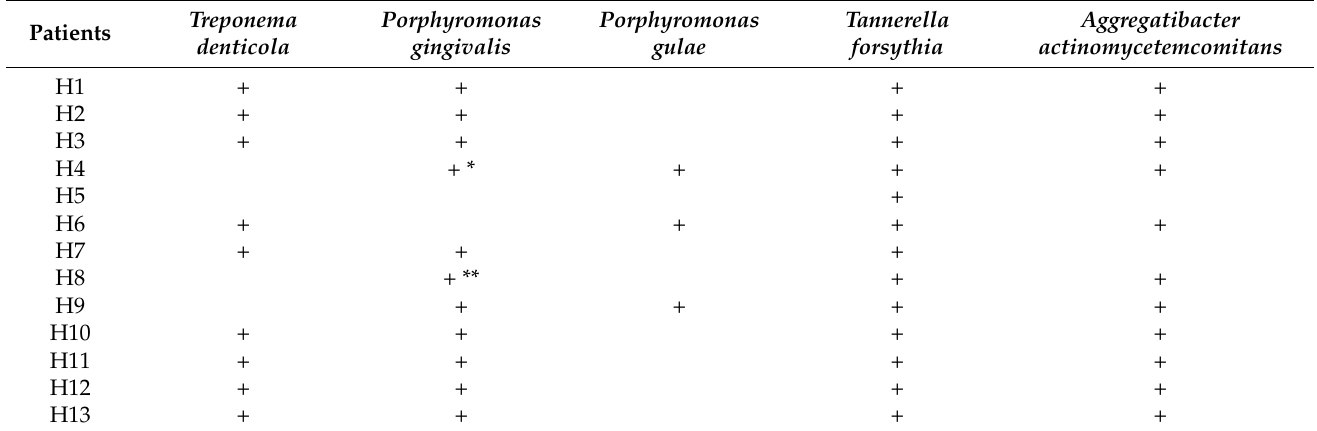
Table 4. The presence of periodontal pathogens in human dental plaque.